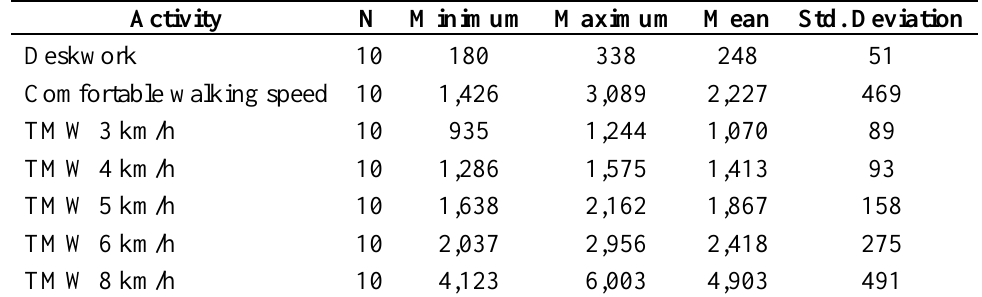
Table 4. Descriptive statistics of mean IMA values per activity at sensor location 2 in 10 −3 m/s 2 . TMW = treadmill